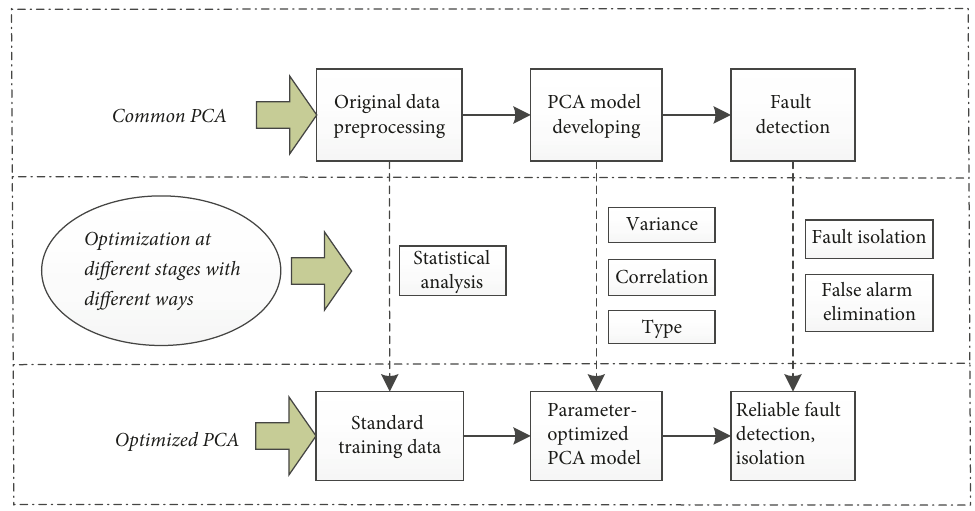
Figure 1: Optimization framework of PCA in this paper.